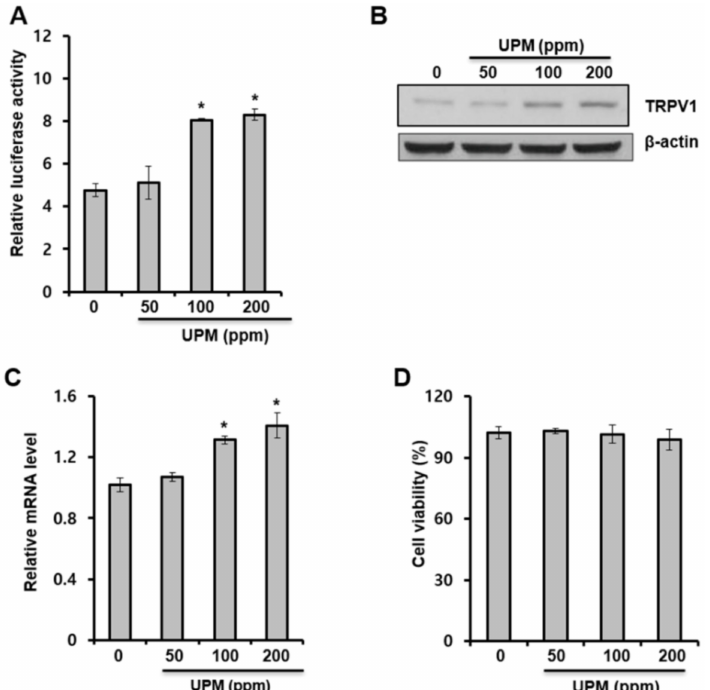
Figure 1. Urban particulate matter upregulates transient receptor potential vanilloid 1 (TRPV 1) gene expression in human keratinocytes. ( A ) HaCaT cells were transfected with the TRPV 1-Luc reporter along with a Renilla-luciferase expression vector that was driven by a thymidine-kinase promoter using DharmaFECT ® Duo transfection reagent according to the manufacturer’s protocols. After 24 h, the cells were incubated in the presence of the indicated concentrations of UPM for 14 h. The cells were subjected to luciferase reporter assay. p < 0.05 vs. control. ( B – D ) HaCaT cells were incubated with the indicated concentrations of UPM for two days. Western blot analysis for TRPV 1 was performed on the cell lysates ( B ), and the mRNA levels of the indicated genes were measured using quantitative real-time PCR (qRT-PCR) analysis ( C ). The expressed results are relative to the untreated cells after normalization against the GAPDH level. In addition, viability of cells exposed to urban particulate matter (UPM) was measured using WST-1 assay ( D ). * p < 0.05 vs. control. The results were